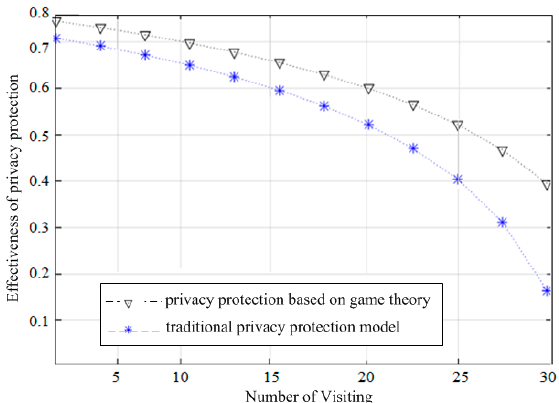
Figure 5. Comparison of the privacy protection between the traditional and game-based protection models.